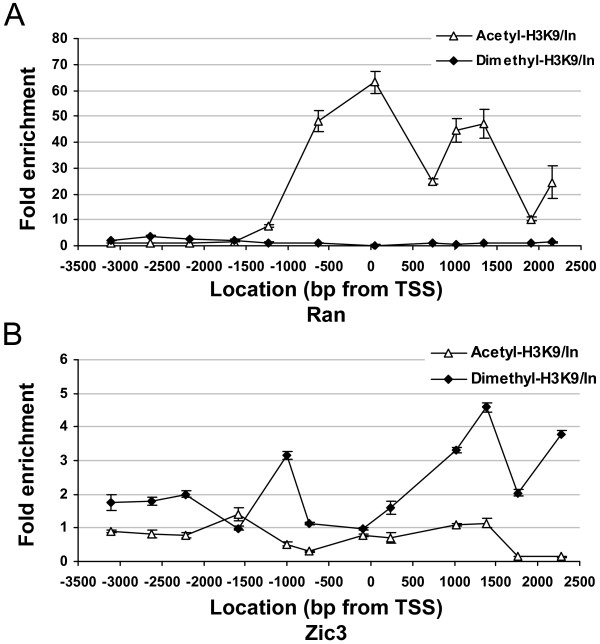
The promoter landscape of histone modifications. The fold enrichment by ChIP-chip with acetyl-H3K9 and dimethyl-H3K9 antibodies was screened by 12 sets of primers. The 12 PCR positions for each gene are indicated as the distances from transcription start site (0). Each error bar represents the standard deviation calculated from triplicates.